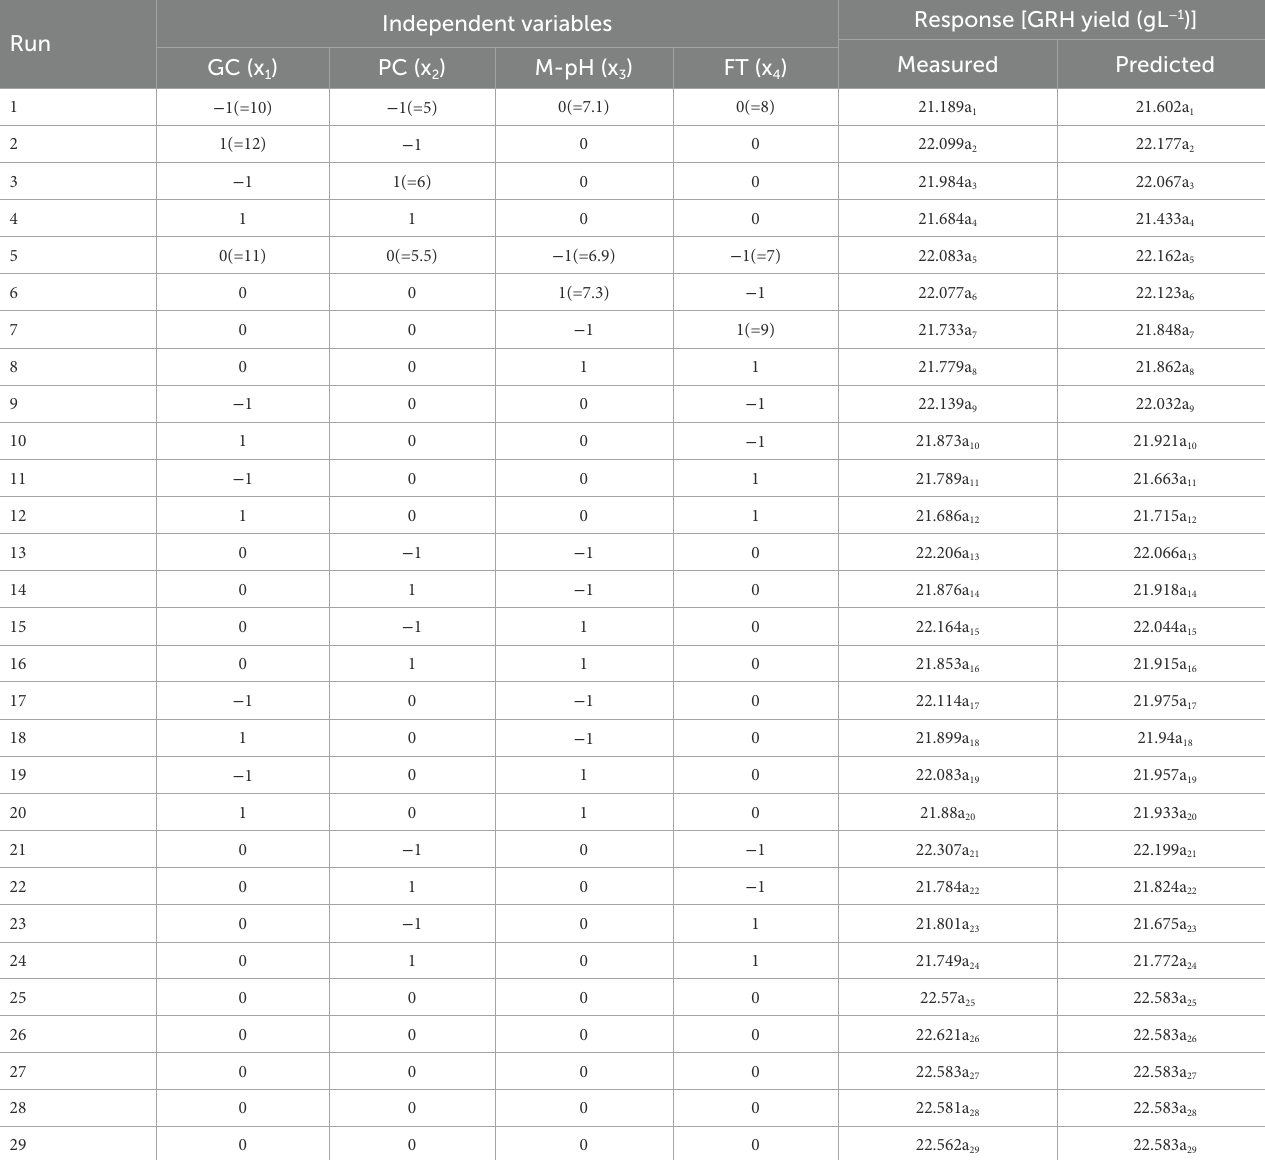
TABLE 3 Experimental design and outcomes of the Box–Behnken Design (BBD) for optimisation of the GRH production from Mucor sp.